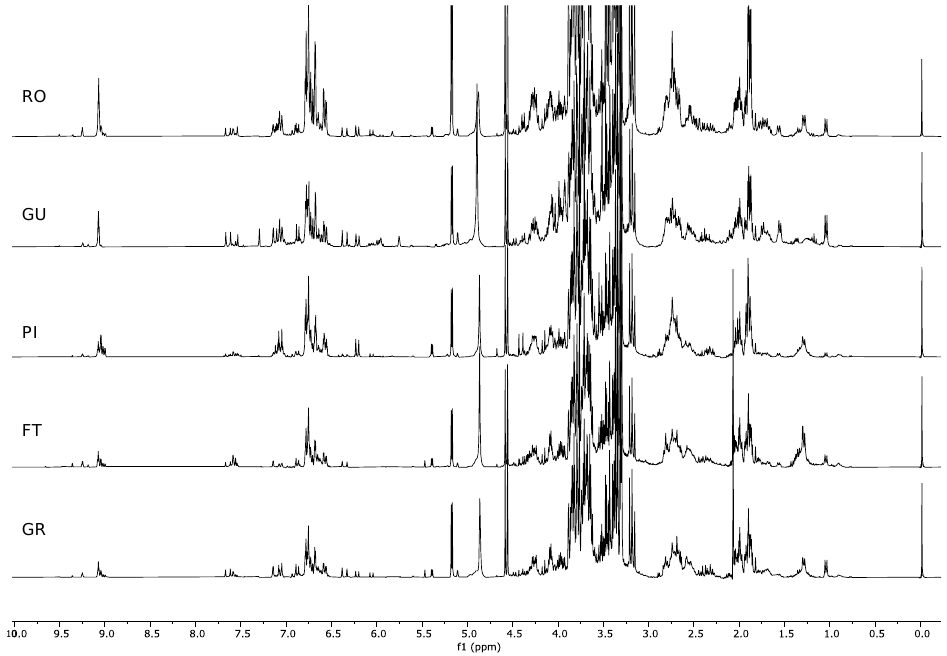
Figure 4. 1 H-NMR spectra of Group II: Cammarotana (CA); Oliva amara (AM), Sanginara (SN), Provenzale (PR), and Marinella (MA).